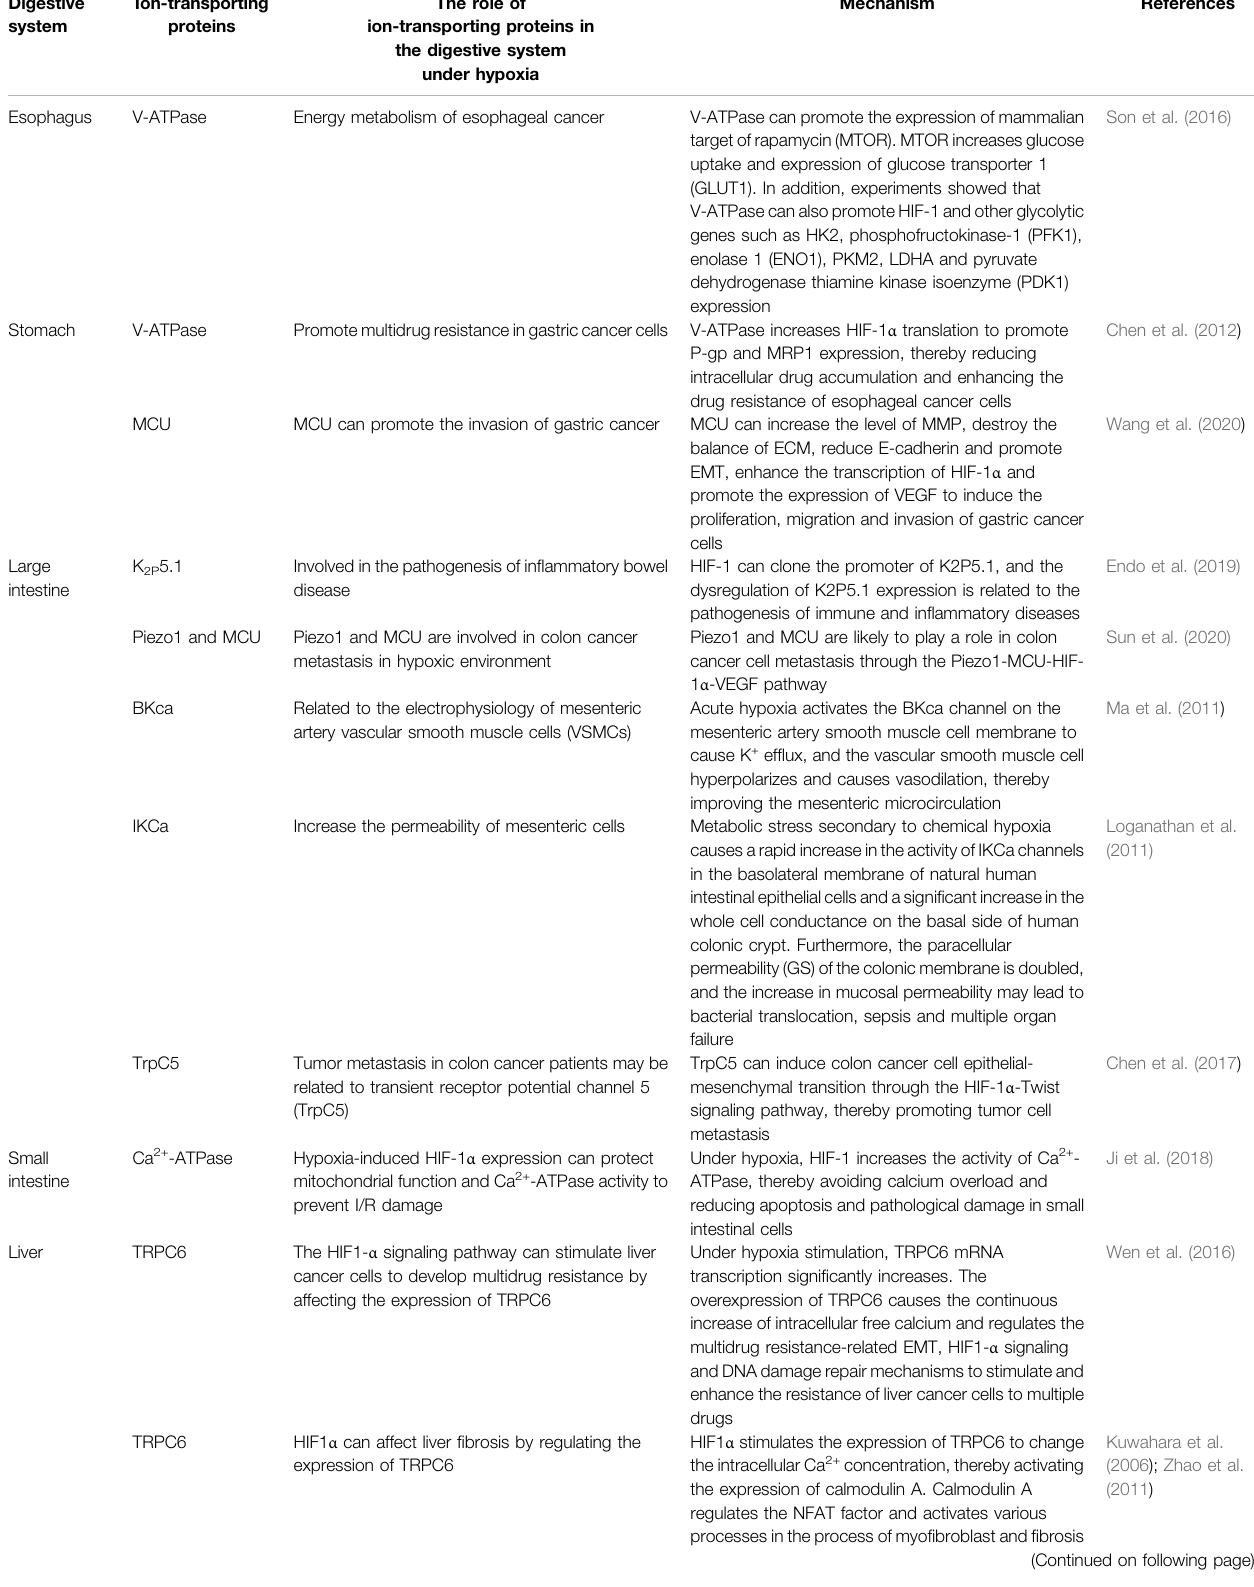
TABLE 1 | The effects of ion-transporting proteins on the digestive system under hypoxic conditions. Digestive